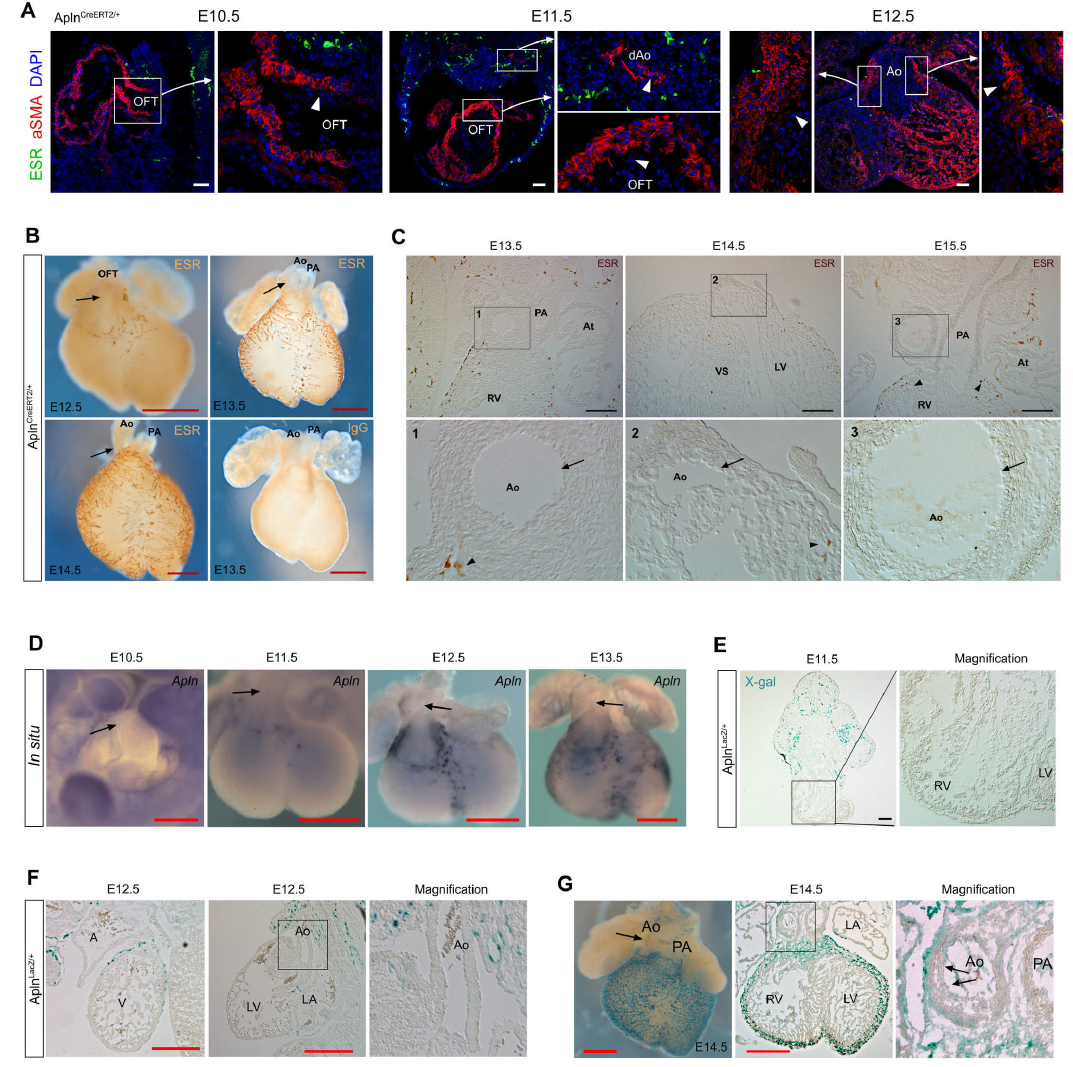
Figure 1. Apln marks coronary vascular endothelial cells but not aortic endothelium. ( A ) Immunostaining of E10.5 to E12.5 AplnCreERT2/+ hearts showed no Apln-driven estrogen receptor (ESR) expression (green) in outflow track or aortic endothelium (arrowheads). Myocardium and great vessel walls were labeled by alpha smooth muscle actin (aSMA, red). DAPI (blue), 4',6- diamidino-2-phenylindole. ( B ) Whole mount ESR staining on E13.5 AplnCreERT2/+ heart. IgG was used as a control. ( C ) Immunohistochemistry (DAB staining) of ESR on E13.5 to E15.5 AplnCreERT2/+ heart sections showed no ESR/Apln expression in aortic endothelium (arrows). Arrowheads denote coronary endothelial cells. ( D ) In situ hybridization of Apln on E10.5-E13.5 hearts. Arrows indicate the outflow tract or aorta, which did not detectably express Apln . ( E - G ) Whole mount and sections of AplnLacZ/+ embryonic hearts after X-gal staining. Note dense staining of coronary endothelia cells but not the aorta. Arrows indicate aorta endothelium that is negative for Apln expression. White bar = 100 um; black bar = 200 um; red bar = 0.5 mm. At, atrium; RV, right ventricle; LV, left ventricle; A, atrium; V, ventricle; Ao, aorta; PA, pulmonary artery; VS, ventricle septum;OFT, outflow tract; dAo, dorsal aorta. Each representative of 3 - 4 hearts. doi: 10.1371/journal.pone.0080857.g001 PLOS ONE |